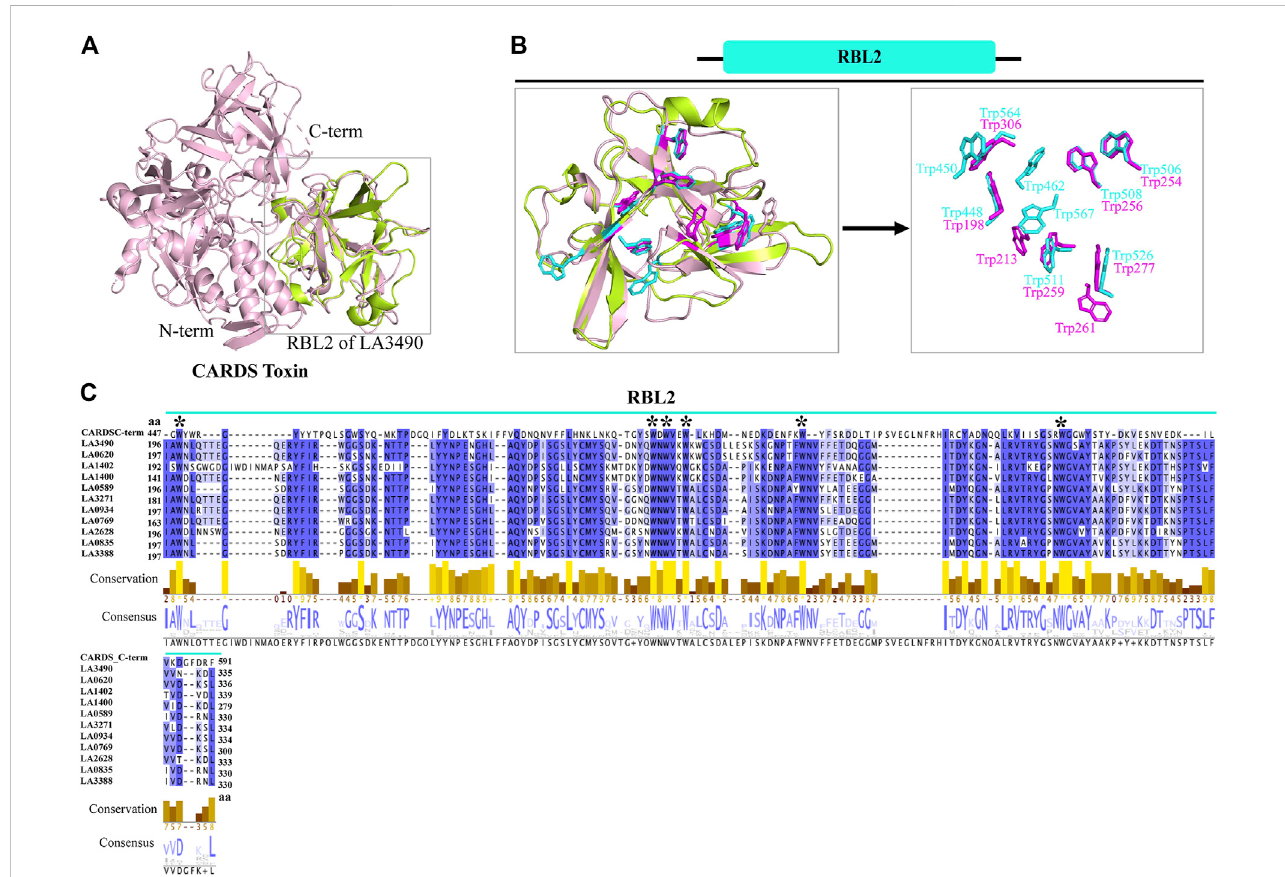
FIGURE 3 Structural and functional similarity of RBL2 of VM proteins with CARDS toxin (D3 domain). (A) The RBL2 domain of LA3490 VM protein (green color: 196 aa — 335 aa) structurally superimposed with the C-terminal region of CARDS toxin (PDB: 4TLV, A chain, pink color) having RMSD 1.218 Å (B) C-terminal regionofCARDStoxin(D3domain)encodesforeighttryptophanandLA3490VMproteinencodesninetryptophanresidues.Sixofthetryptophanresiduesare structurallysuperimposedinboththeC-terminalregionofCARDStoxinandtheRBL2domain. (C) MultiplesequencealignmentofparalogsofRBL2from L. interrogans serovar Lai was performed using MAFFT algorithm and visualized in JalView. Six conserved tryptophan residues shown by *